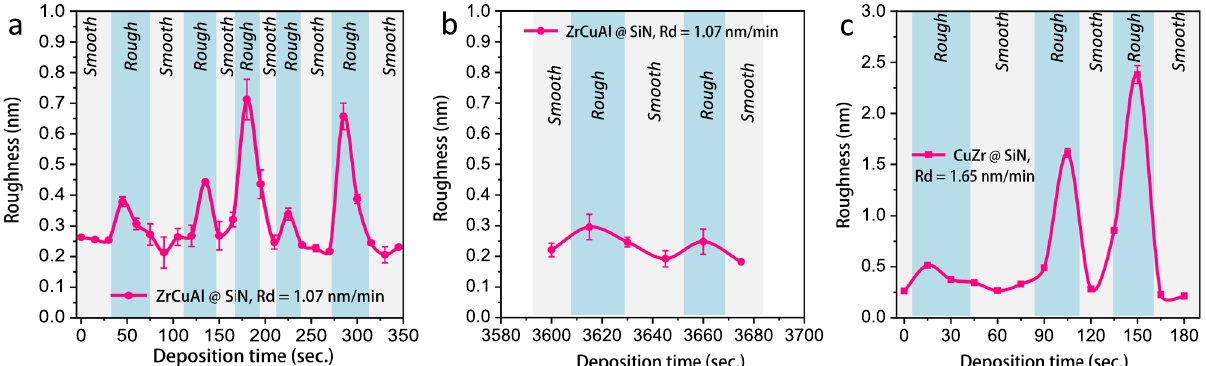
Fig. 2 Variation in surface roughness of UMG. The variation of surface roughness as a function of deposition time for Zr 46 Cu 46 Al 8 fi lms deposited on Si 3 N 4 substrate at a deposition rate of 1.07 nm min − 1 . a The roughness change in the initial stage of deposition. b The roughness change at longer deposition time. c Cu 50 Zr 50 fi lms deposited on Si 3 N 4 substrate at a deposition rate of 1.65 nm min − 1 over time from 0 s to 180 s. The error bars indicate the standard deviation from fi ve measurements.